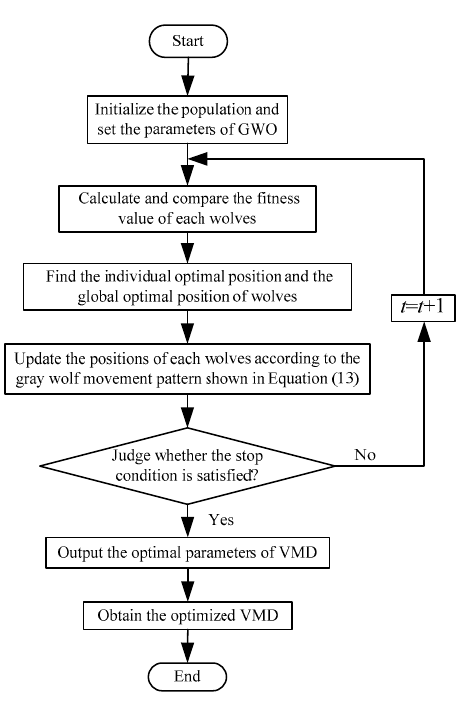
Figure 5. A population hierarchy of the GWO algorithm.